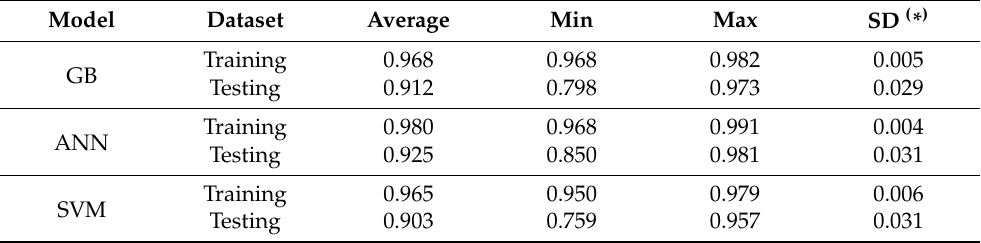
Table 4. Summary of the 300 samplings using R criteria.